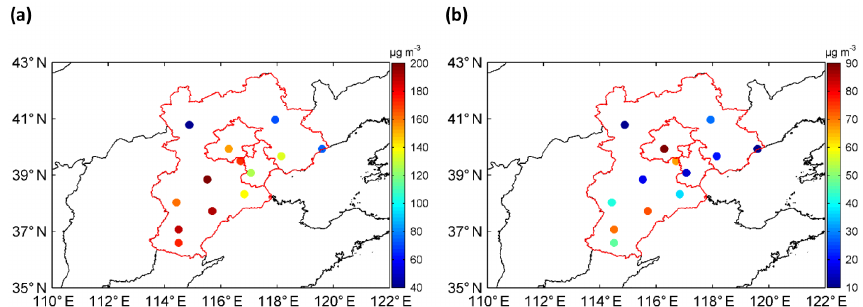
Figure 1. (a) Monthly mean PM 2 . 5 concentrations in December 2015 and (b) the change of monthly mean PM 2 . 5 concentrations in December between 2015 and 2014 over the Jing-Jin-Ji area.